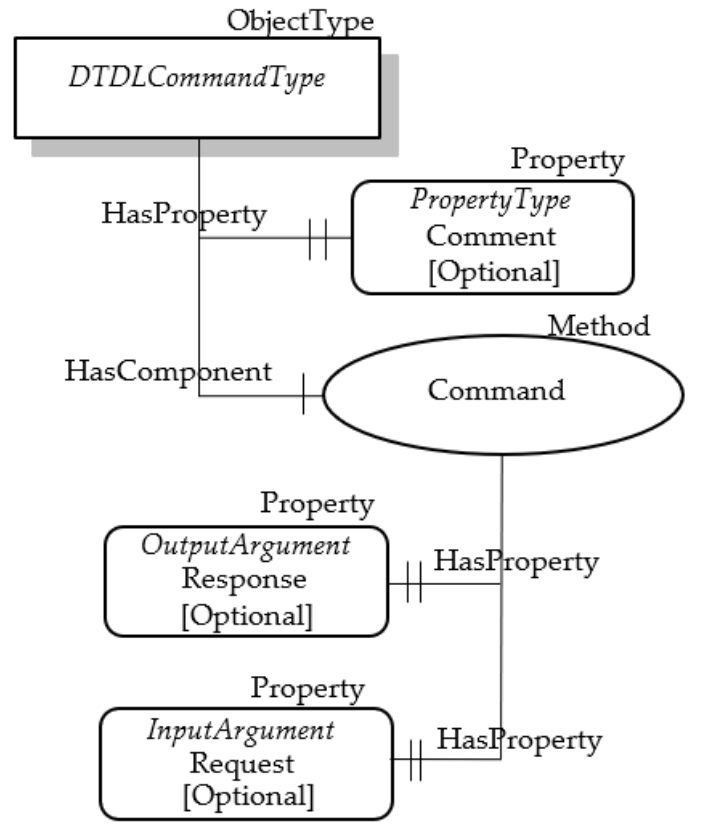
Figure 7. OPC UA DTDLCommandType. Table 11. Properties of the Relationship